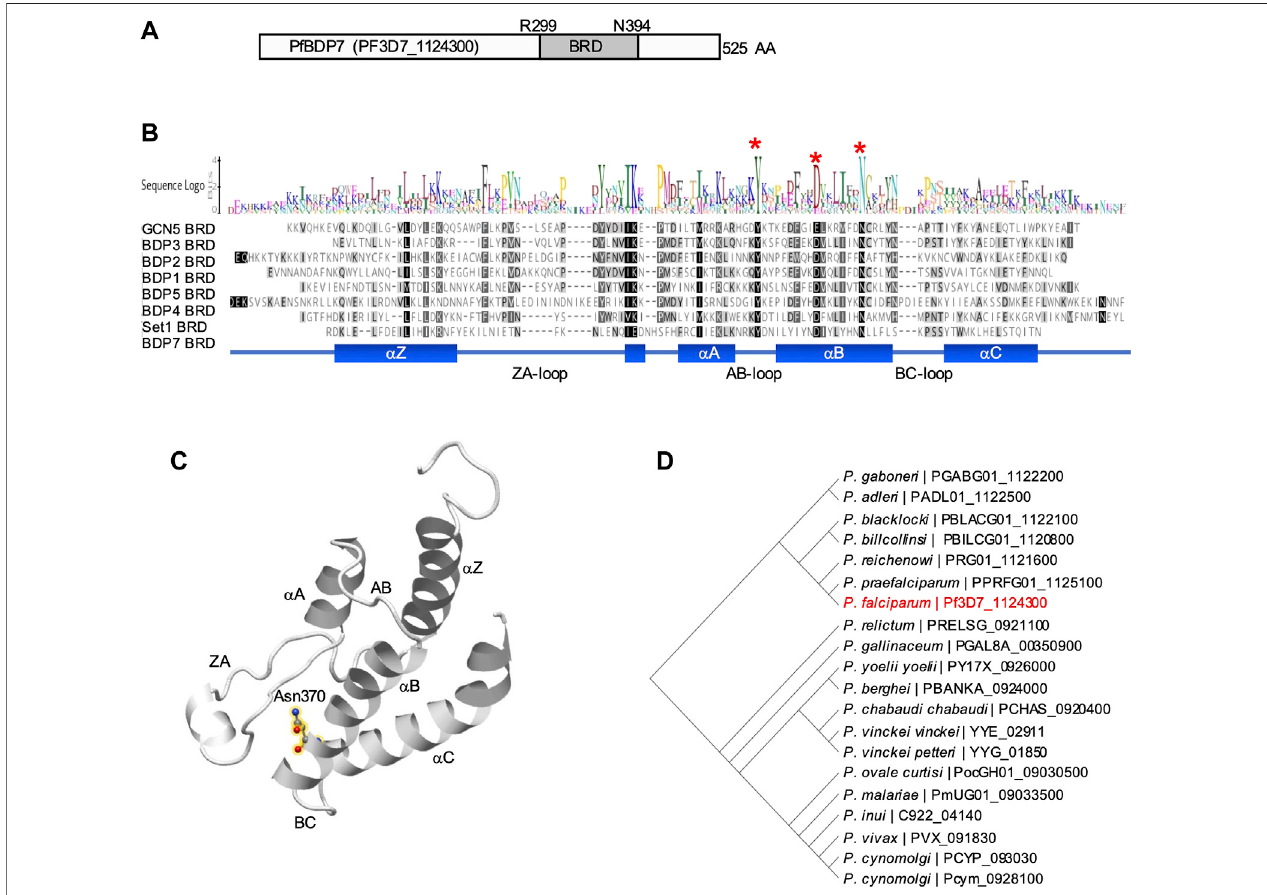
FIGURE1| StructurepredictionofPfBDP7. (A) ModelofPfBDP7withtheputativebromodomain(BRD)fromR299toN394highlightedindarkgrey. (B) Alignment of P.falciparum bromodomainsincludingthemodelledPfBDP7domain.Aminoacidsareshadedbydegreeofsimilarity.Thesequencelogodepictsconservedresidues. Structural features ( α Z, α A, α B, α C helices with inter-helical connecting loops ZA-, AB- and BC-loops) are indicated at the bottom. The conserved Y and D residues stabilizing the bromodomain fold, and the conserved N critical for Kac binding are indicated by red asterisks. (C) Structural model of the PfBDP7 bromodomain predicted by Phyre2. The structural features characteristic for the bromodomain fold are labelled. The conserved N370 is highlighted in yellow halos. (D) Phylogenetic tree of PfBDP7 orthologs identi fi ed in the Plasmodium genus. PF3D7_1124300 (PfBDP7) is labelled in red.